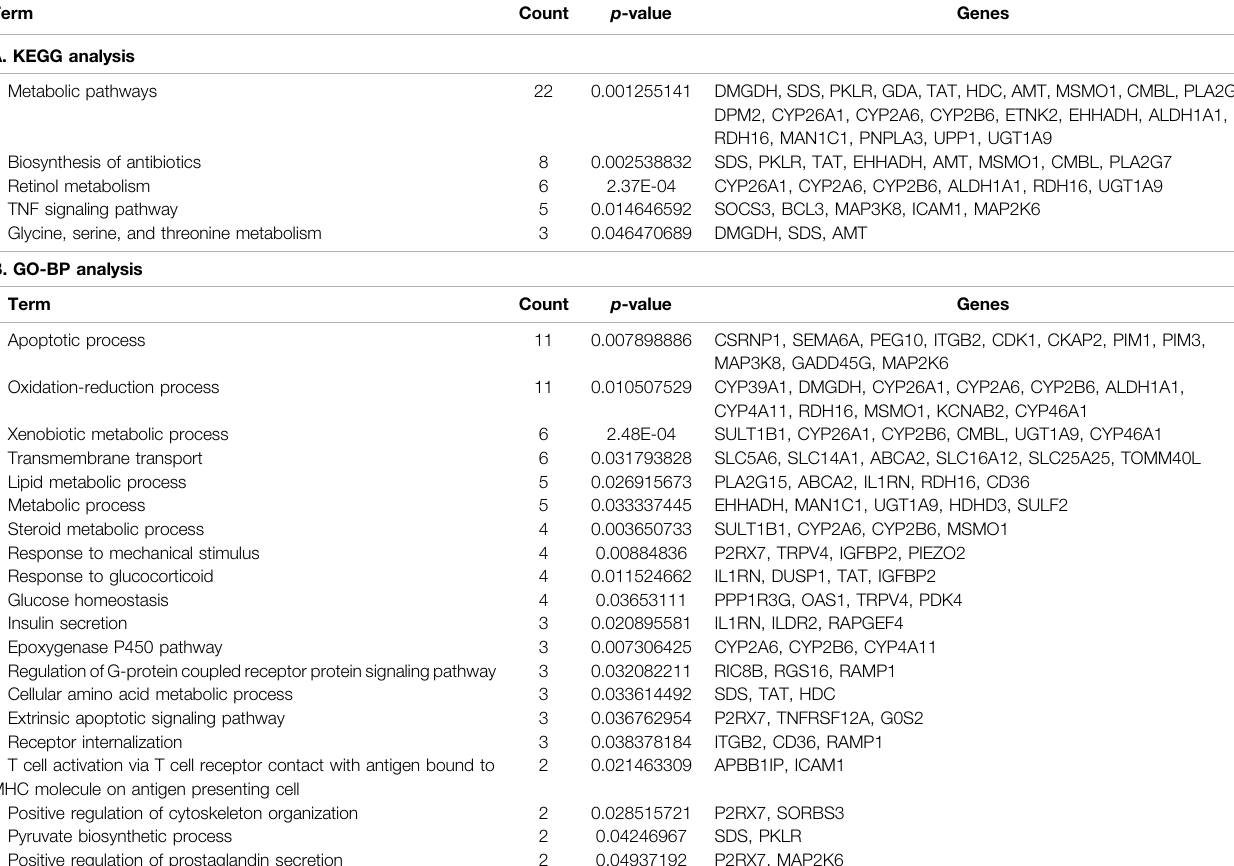
TABLE 2 | DAVID functional annotation for overlapping